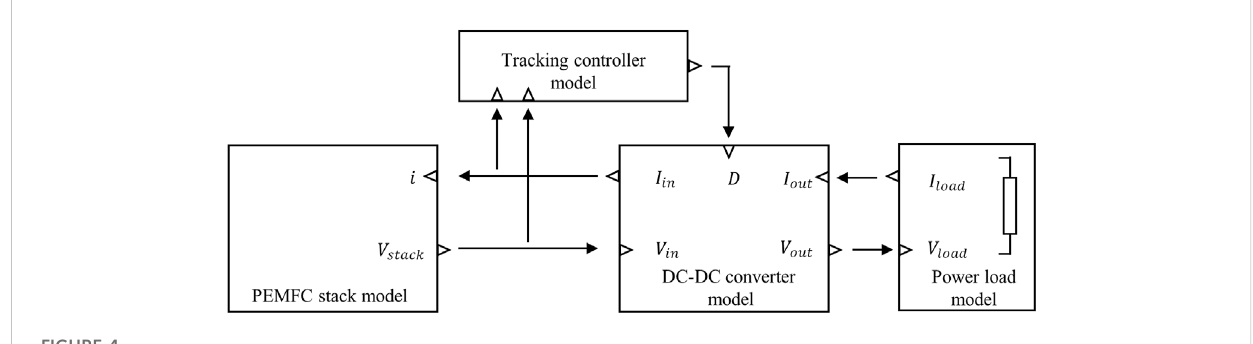
FIGURE 4 Structure of the system-level model.